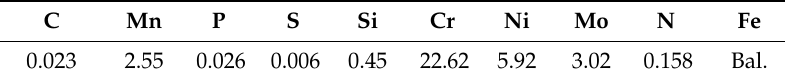
Figure 1. Schematic diagram of industrial processing steps associated with the duplex stainless steel (DSS) specimens investigated in this study. Table 1. Chemical composition of the studied DSS (wt. %).